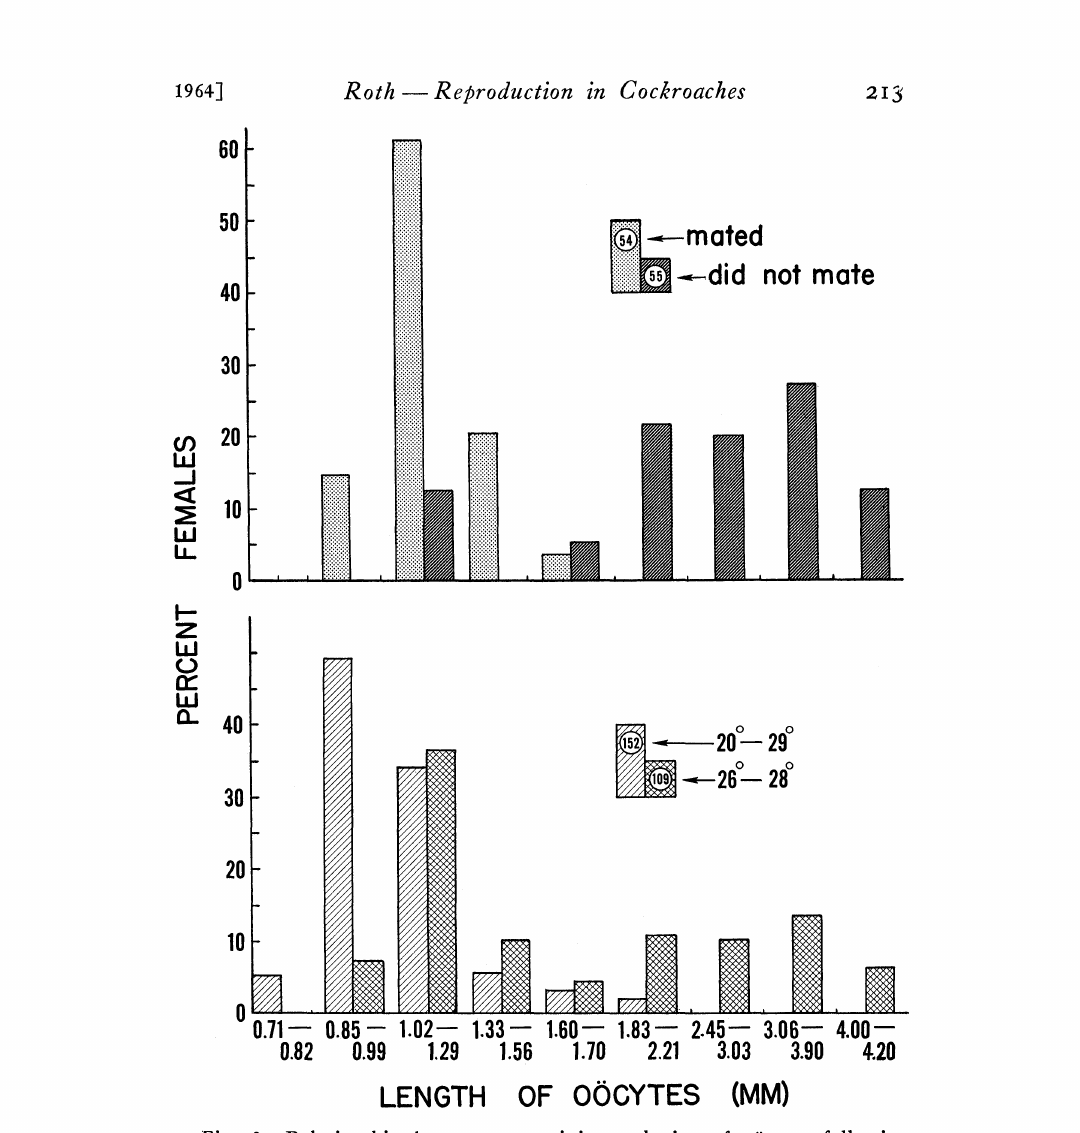
. , elatiosbip betee eceptiity ad size o o6cytes olloi ig. c{r. op* Zemales exposed to ales patuitio i patuitio ad gie b. to mate. O6cytes ater patuitio (2 C.). otom" O6cyte measured at the time o patuitio o 2 b. ate the emales bad gie birth.